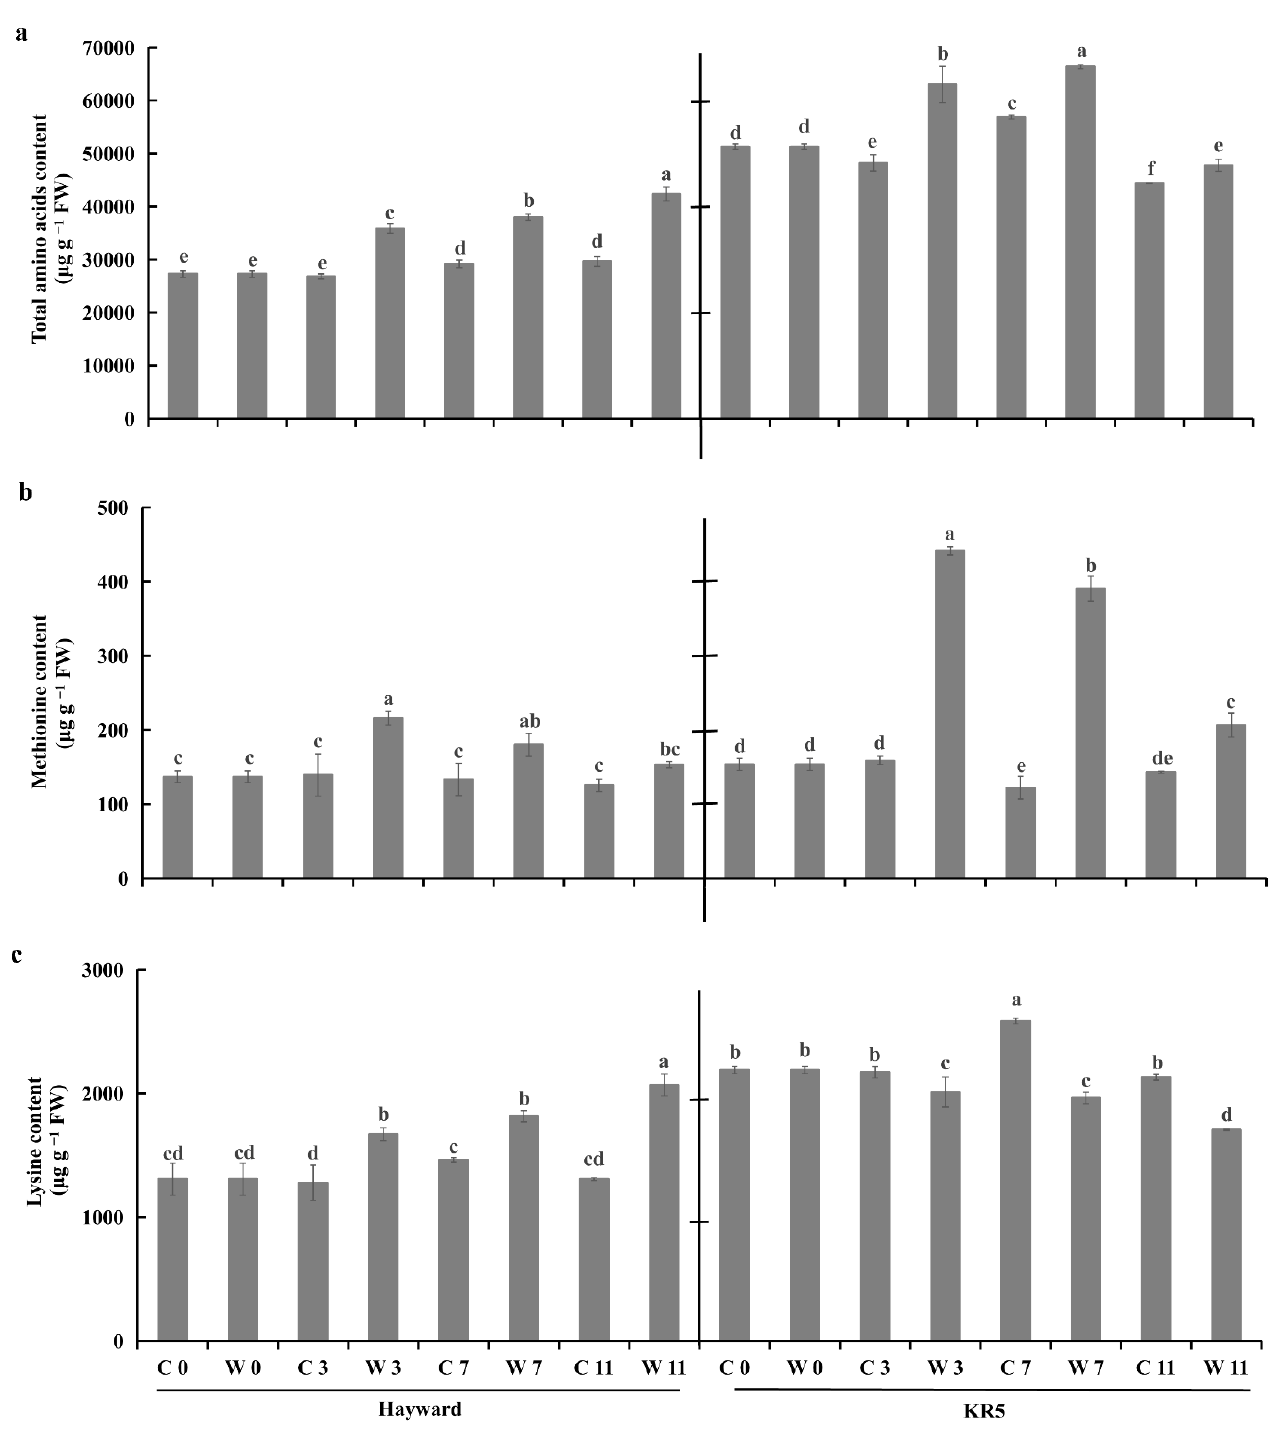
Figure 9. Concentrations of ( a ) total amino acids, ( b ) methionine, and ( c ) lysine in roots of ‘Hayward’ and KR5 under control and waterlogging conditions. C 0, C 3, C 7, and C 11 indicate 0, 3, 7, and 11-d controls, respectively. W 0, W 3, W 7, and W 11 indicate waterlogging treatments of 0, 3, 7, and 11 d, respectively. Values are the mean ± SD ( n = 3). Significant differences between treatments per genotype at p < 0.05 are indicated by different letters over columns (Duncan’s test).